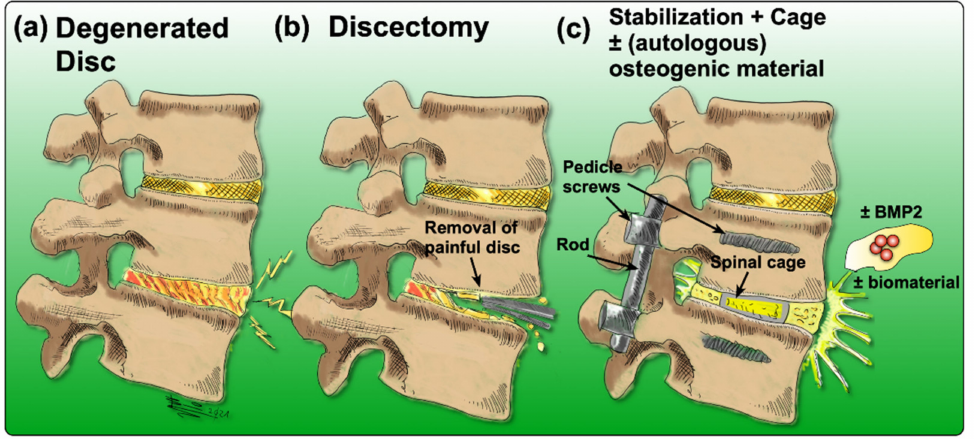
Figure 2. Drawing of the process of achieving spinal fusion: ( a ) the degenerated disc diagnosed by means of imaging, ( b ) discectomy of the degenerated disc, ( c ) stabilization of the spine by insertion of a cage (to maintain the disc height as a spacer) and the addition of an osteoconductive and/or osteoinductive filler material; optionally, BMP2 may be added, coupled with or without a